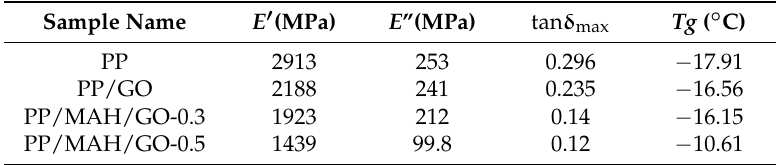
Table 1. The DMA analysis results of pure PP and composite fibers.